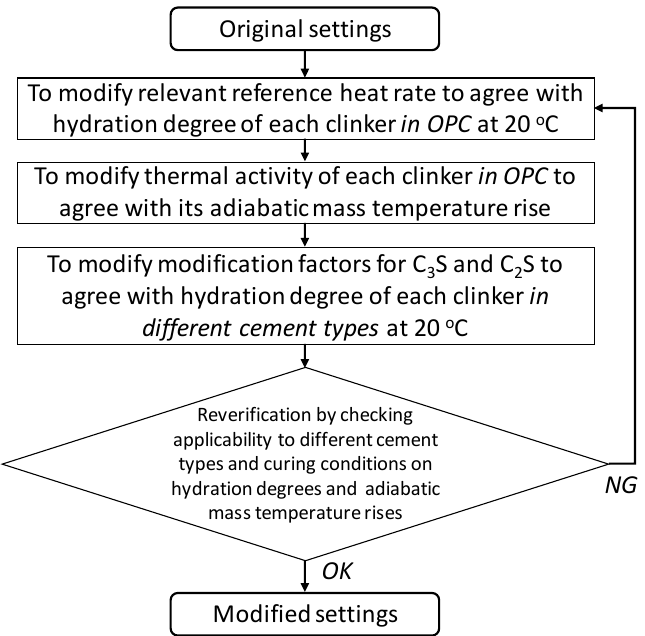
Figure 8. Procedure of the repetitive modification study.